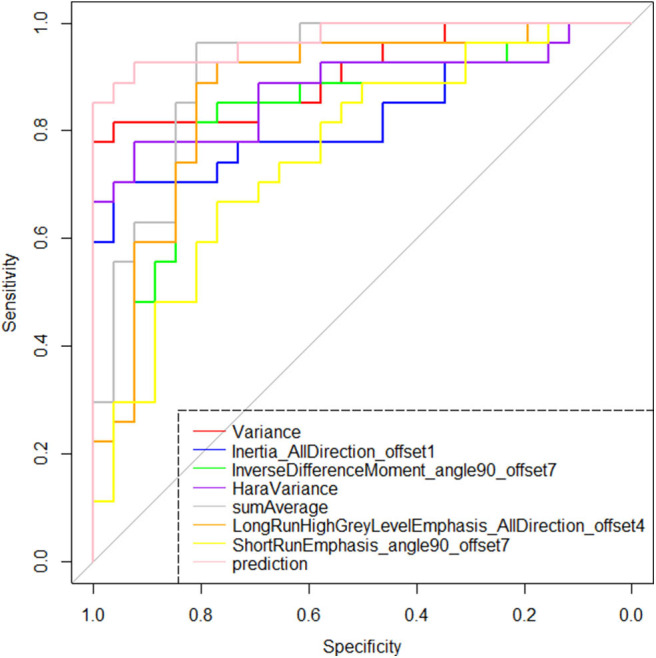
Receiver operating characteristic plots of the selected seven features and the model's prediction probability based on them. According to the area under the curve index, the identification effectiveness of the binary logistic regression model based on the seven features is greater than the discrimination performance of any single feature.